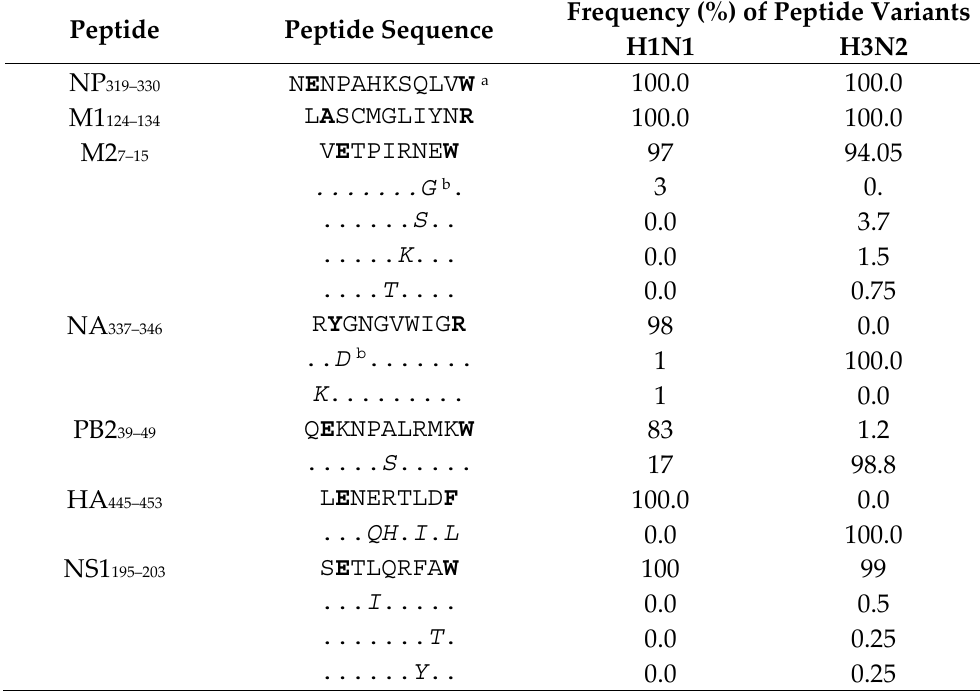
Table 2. Conservancy of the novel epitope sequences among all the IAV strains circulated in Australia during 1971–2021.